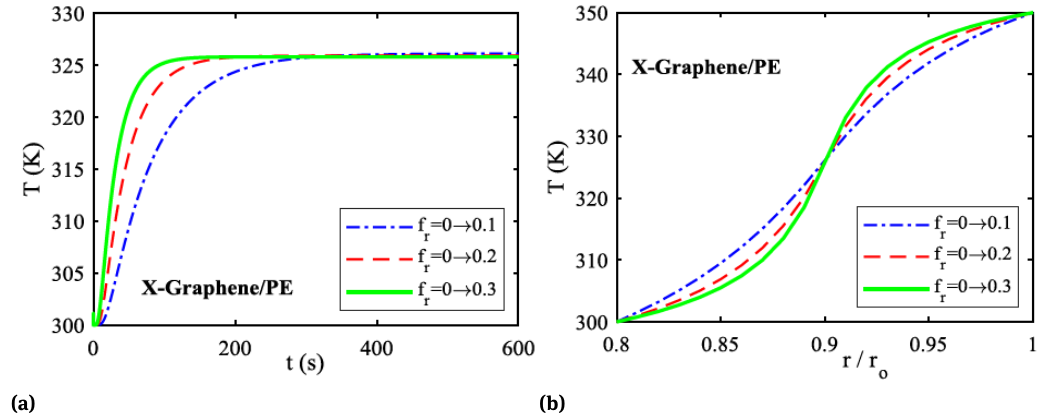
Figure 10: a) Temperature time histories of mid points b) Steady state temperature profiles at z = L /2 in X-graphene/PE cylinders